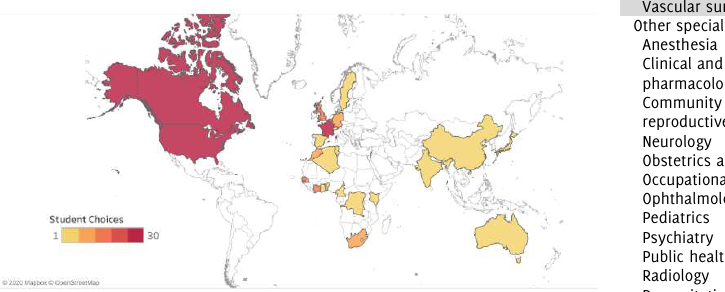
Figure 1 . Preferred Destinations of Cameroonian and Congolese Senior Medical Students for Postgraduate Medical Training.